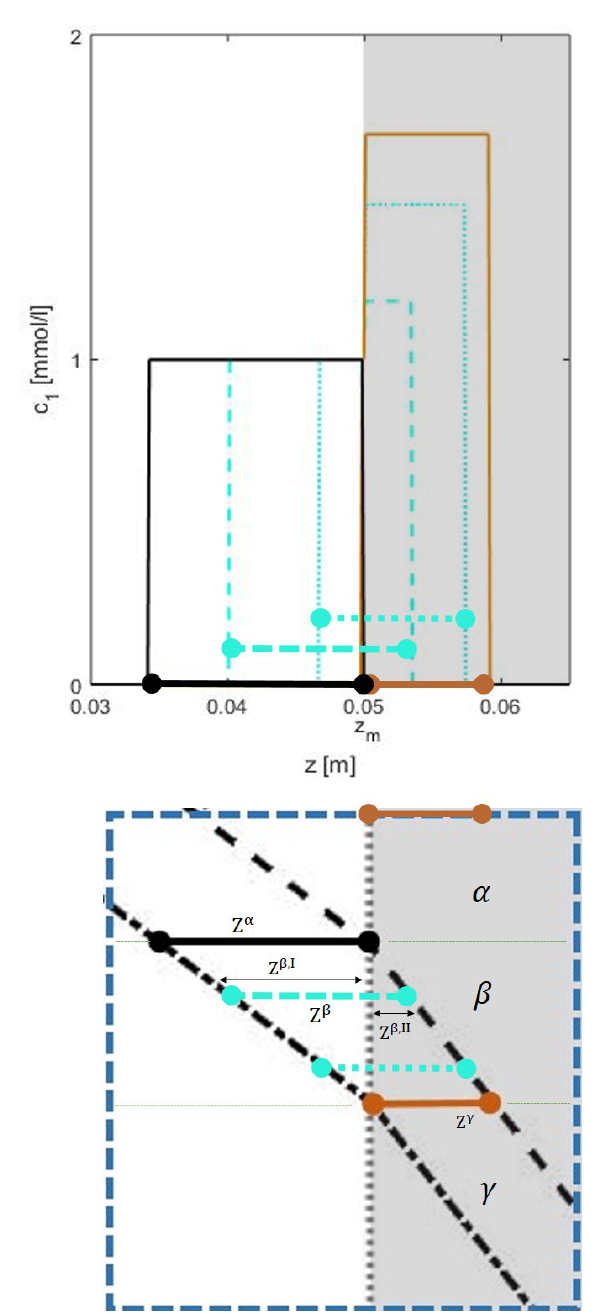
Figure 4. Illustration of the solution behavior in the intermediate state β for cooling of Type I: The state β , highlighted by blue colored dashed boundary in Figure 3, is rotated clockwise along with the corresponding portion of the z -plot. The pulse is shown at two places by cyan color, using dashed line when most of its part is in segment I and, by dotted line when most of its part is in segment II. As the sapce-bandwith gradually changes in state β , the corresponding concentration also changes accordingly. All the space-bandwidths (Z α , Z β ,I , Z β ,II , Z γ ) can be calculated using Equation